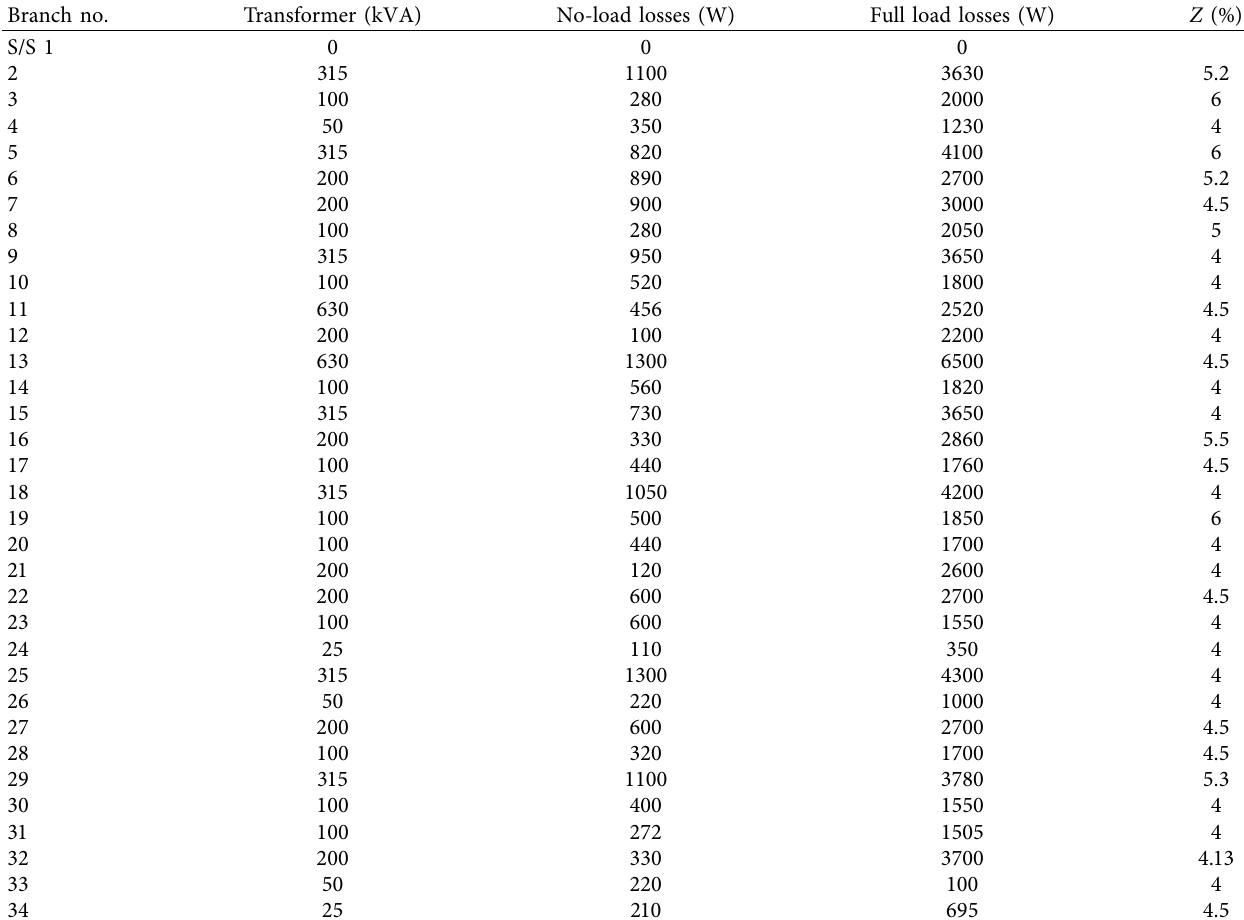
Table 5: Transformer data of the distribution system.